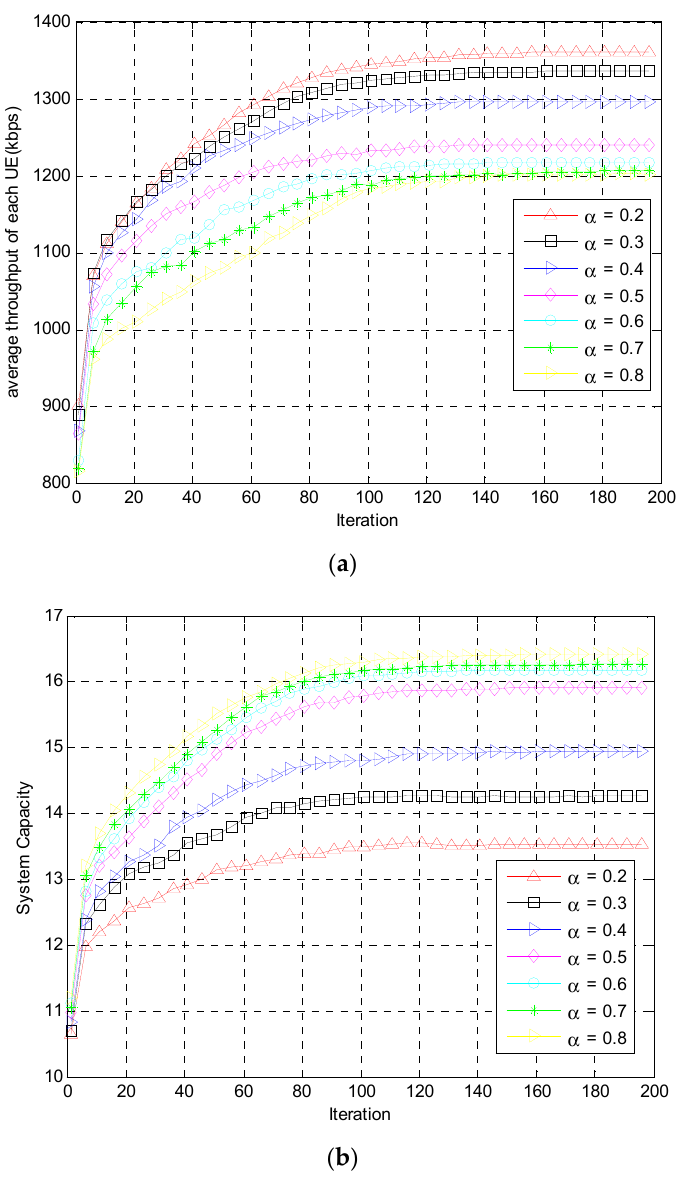
Figure 7. System performance comparisons in 200 generations for ( a ) throughput and ( b ) system capacity with K = 18.